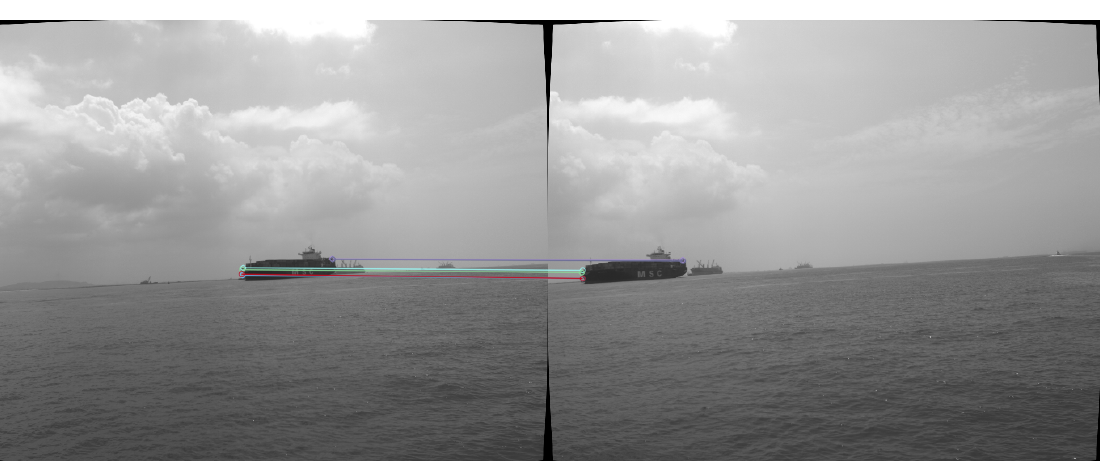
Figure 6. ORB feature detection, tracking, and matching. The straight lines in the image connecting the matched